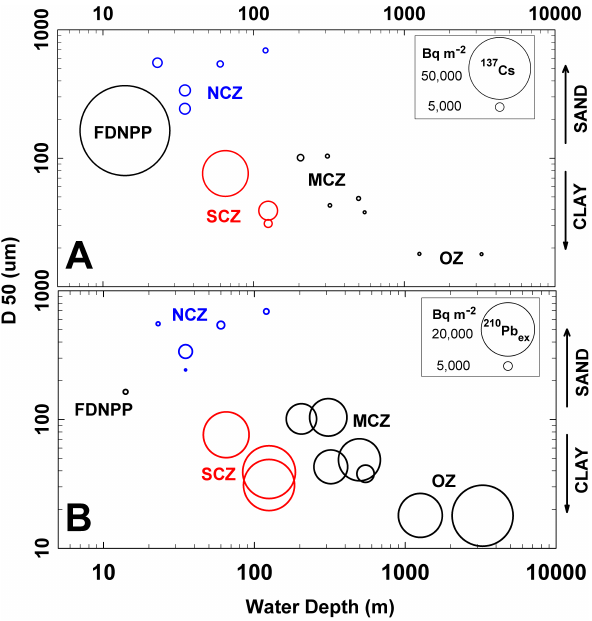
Figure 3. 137 Cs and 210 Pb ex inventories relative to water depth and D50. Grain size distribution is shown for 16 of the 20 cores, includ- ing all of the NCZ, SCZ, and MCZ cores. Isotope inventories for 134 Cs (a) and 210 Pb ex (b) show general depth trends with promi- nent grain size effects in the NCZ and